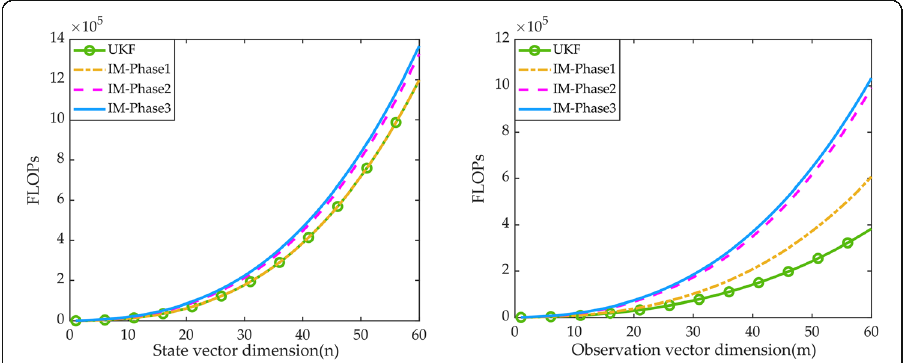
Fig. 6 Computational complexity in FLOPs of different state and observation dimensions. a Observation vector dimension m = 5, n varies from 1 to 60. b State vector dimension n = 3, m varies from 1 to